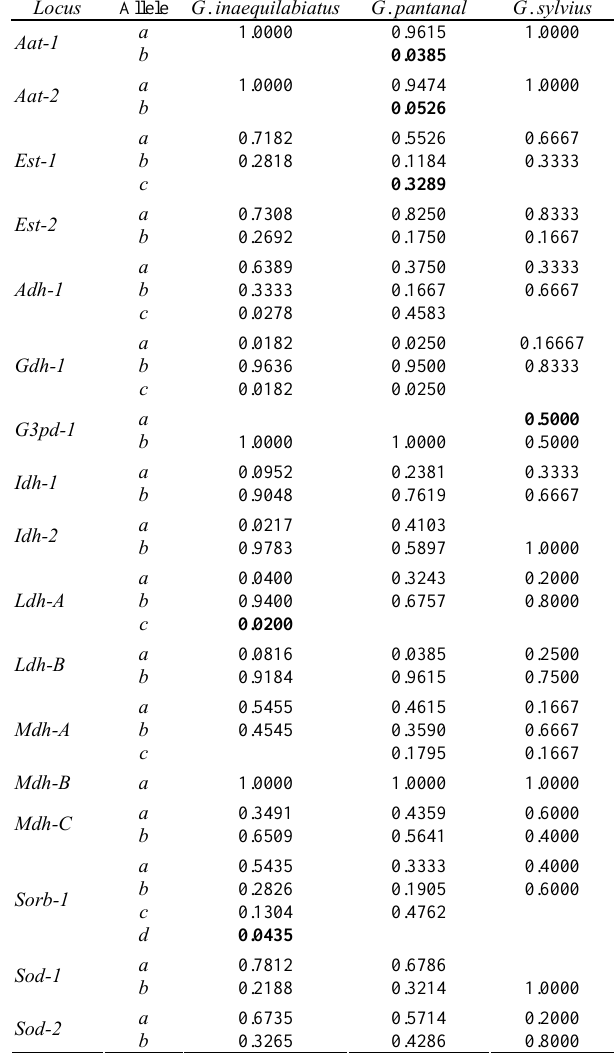
Table 2. Allele frequencies for three Gymnotus species from Caracu stream, Paraná State, Brazil. Bold type indicates exclusive alleles for each species.